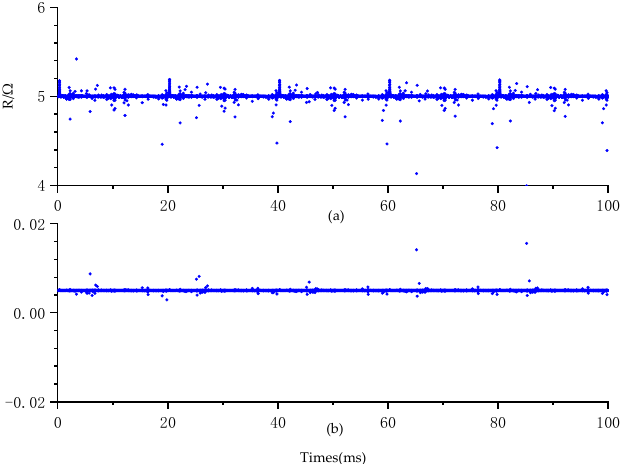
Figure 10. Load parameter identification without background harmonic: ( a ) resistance; ( b ) inductance.